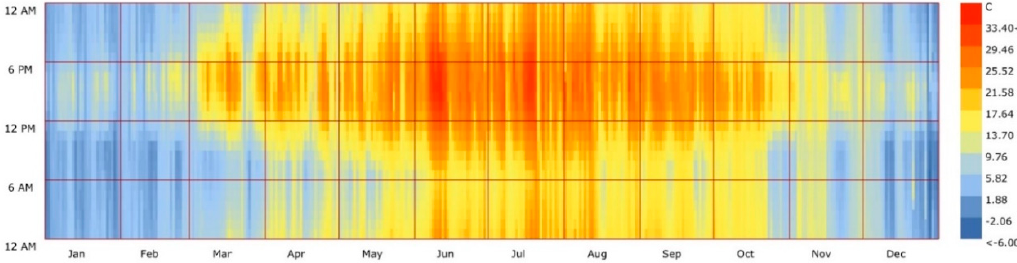
Figure 1. Graph of the dry bulb temperature (°C) in Segno (Tn)—Italy on an hourly time step.